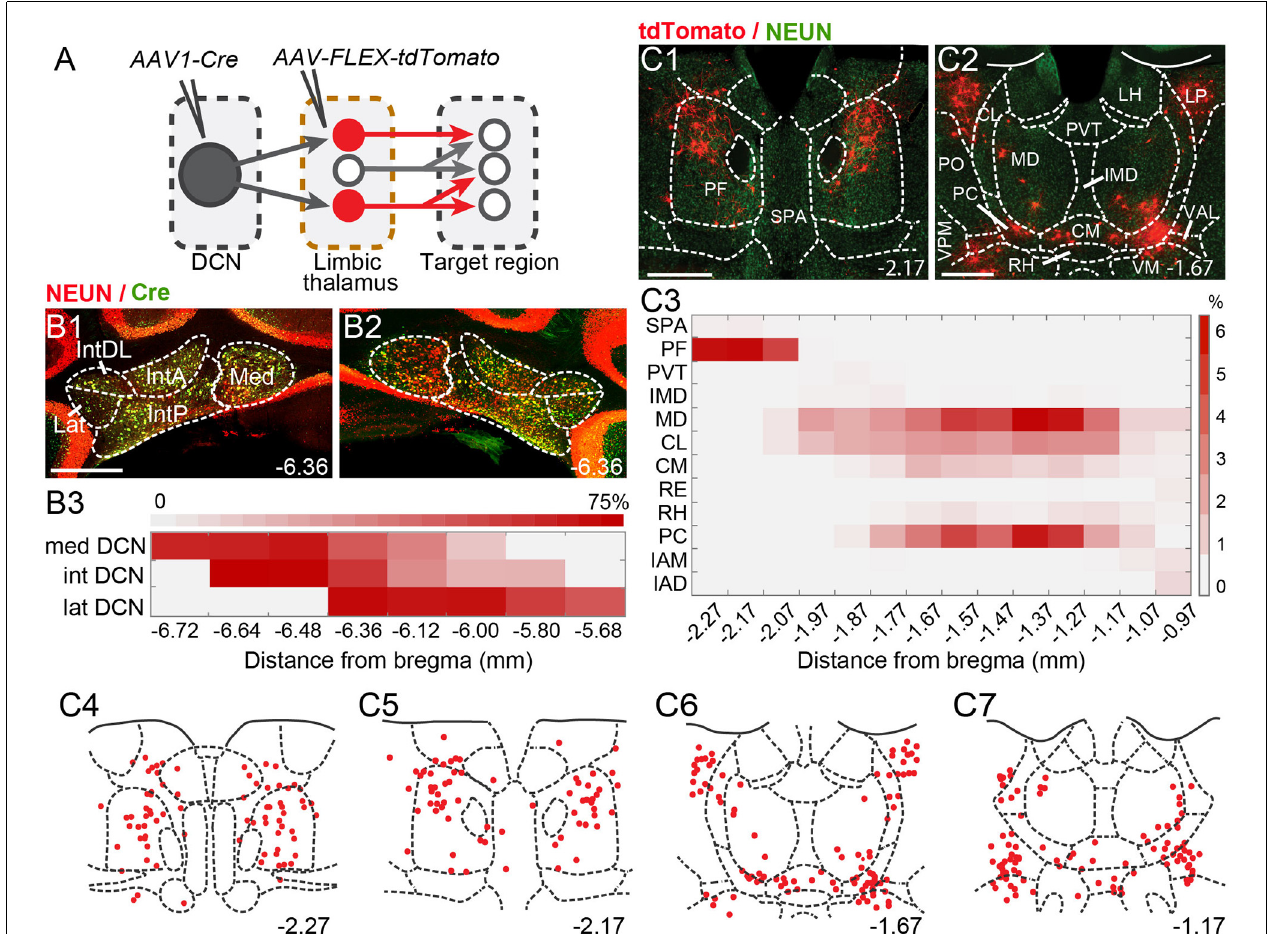
FIGURE 2 | The intralaminar and mediodorsal nuclei are major cerebellar postsynaptic targets in the limbic thalamus. (A) Schematic of experimental approach for disynaptic pathway tracing. (B1,B2) Example images of bilateral Cre expression in DCN. Red: immunofluorescence for NeuN neural marker; Green: anti-Cre immunoreactivity; Yellow: merge. (B3) Heatmap of Cre immunofluorescence in DCN, normalized to NeuN signal and averaged across experiments, as a function of distance (in mm) from bregma. (C1,C2) Example images of thalamic neurons conditionally expressing tdTomato (red) upon transneuronal transfer of Cre from cerebellar presynaptic axons. Green: NeuN immunofluorescence. (C3) Heatmap of the relative distribution of tdTomato+ neurons across thalamic nuclei, normalized to the total number of labeled neurons and averaged across experiments, as a function of distance from bregma. (C4–C7) Example registration of tdTomato+ neurons to the Allen mouse brain atlas. Numbers at the bottom denote distance (in mm) from bregma. Antero-posterior coordinates for each nucleus can be found in Table 1 . Scale bars: 500 µ m.